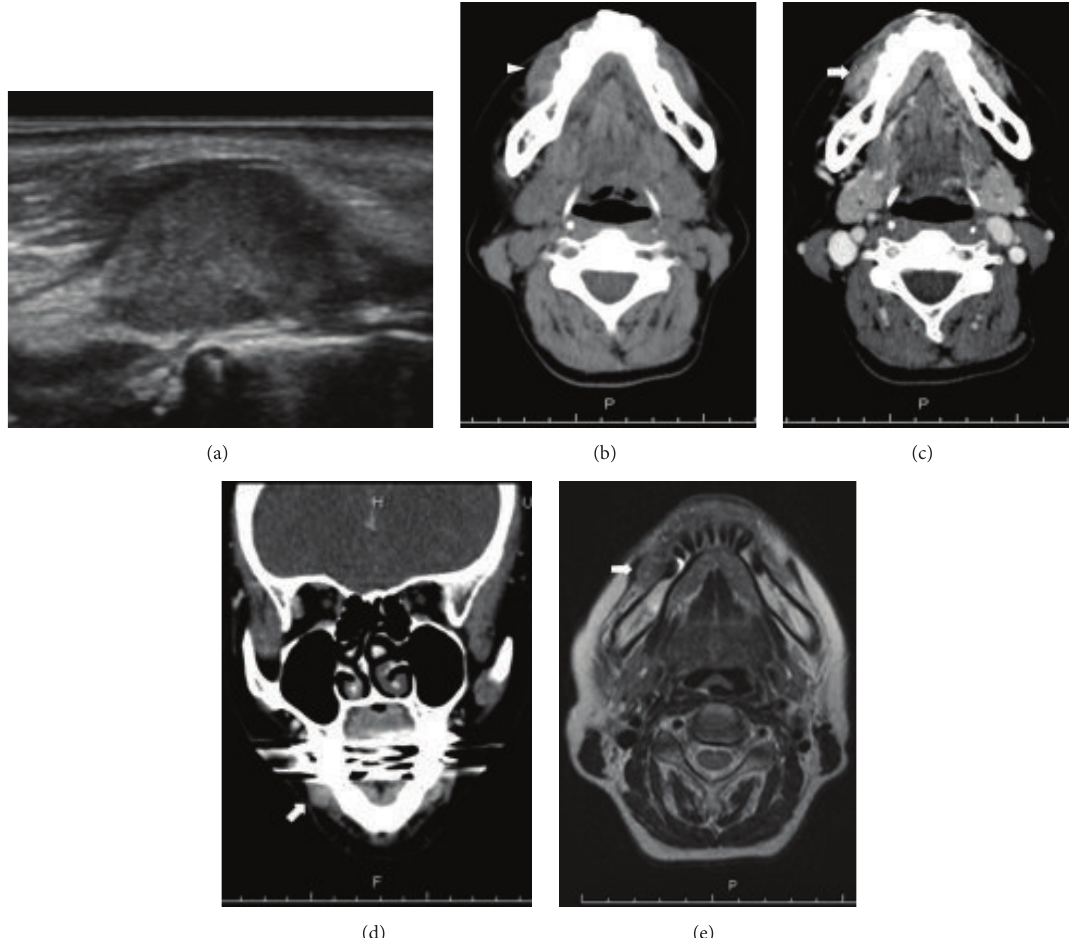
Figure 2: Findings of image examinations of the neck. (a) Echo showed a homogeneous hypo- to isoechoic lesion with a smooth margin. (b) Plain CT, axial view. Homogeneous low-density lesion (arrowhead). (c) Contrast-enhanced CT, axial view. (d) Contrast-enhanced CT, coronal view. Faintly enhanced lesions (arrows) were noted. (e) MRI, T2-weighted image, axial view. MRI showed a homogeneous low- to isointense lesion with partially high intensity